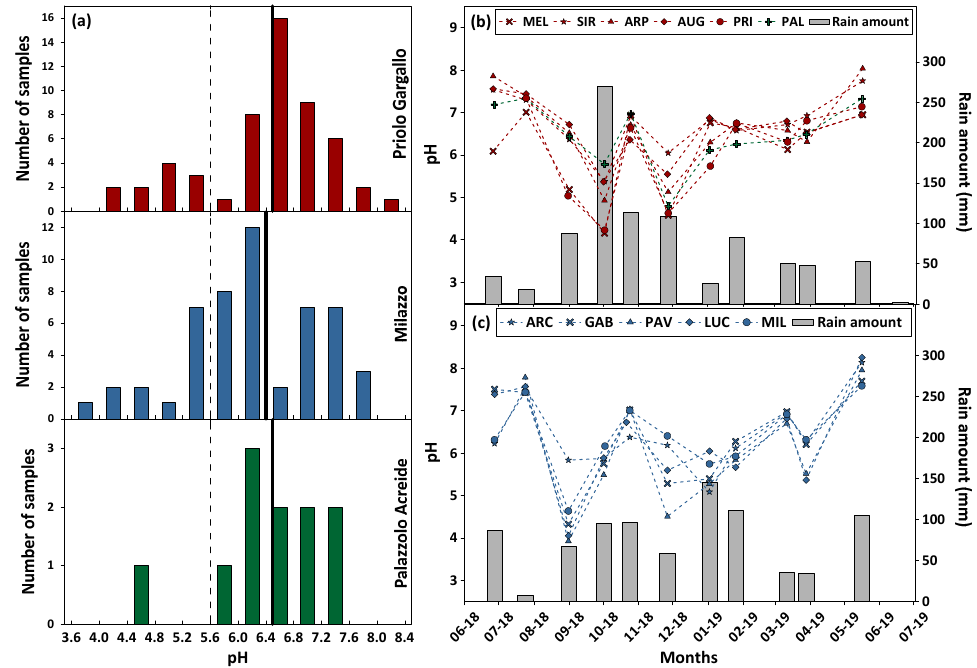
Figure 5. ( a ) The pH values of bulk deposition samples collected from June 2018 to June 2019 at Priolo Gargallo, Milazzo, and Palazzolo Acreide. The dashed line indicates the theoretical pH value expected for unpolluted cloud water at equilibrium with 410 ppm of atmospheric CO 2 . The solid lines indicate the median pH values in the study areas. On the right side, seasonal variability of the pH values and average rain amount at Priolo Gargallo ( b ) and Milazzo ( c ) study areas.